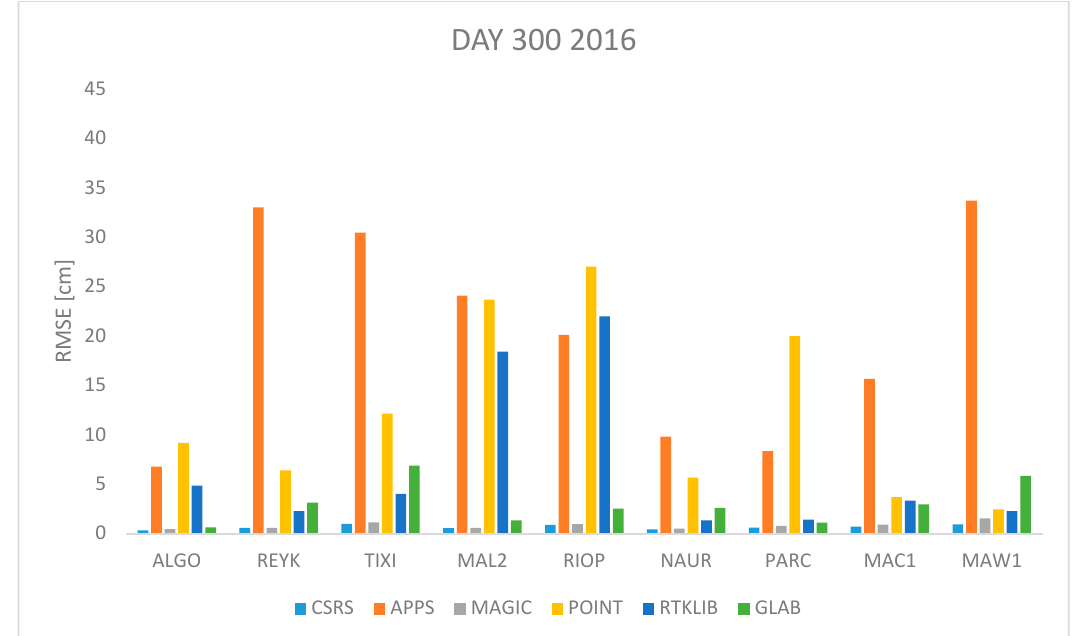
Figure 7. RMSE in centimeters for day 300 in year 2016.